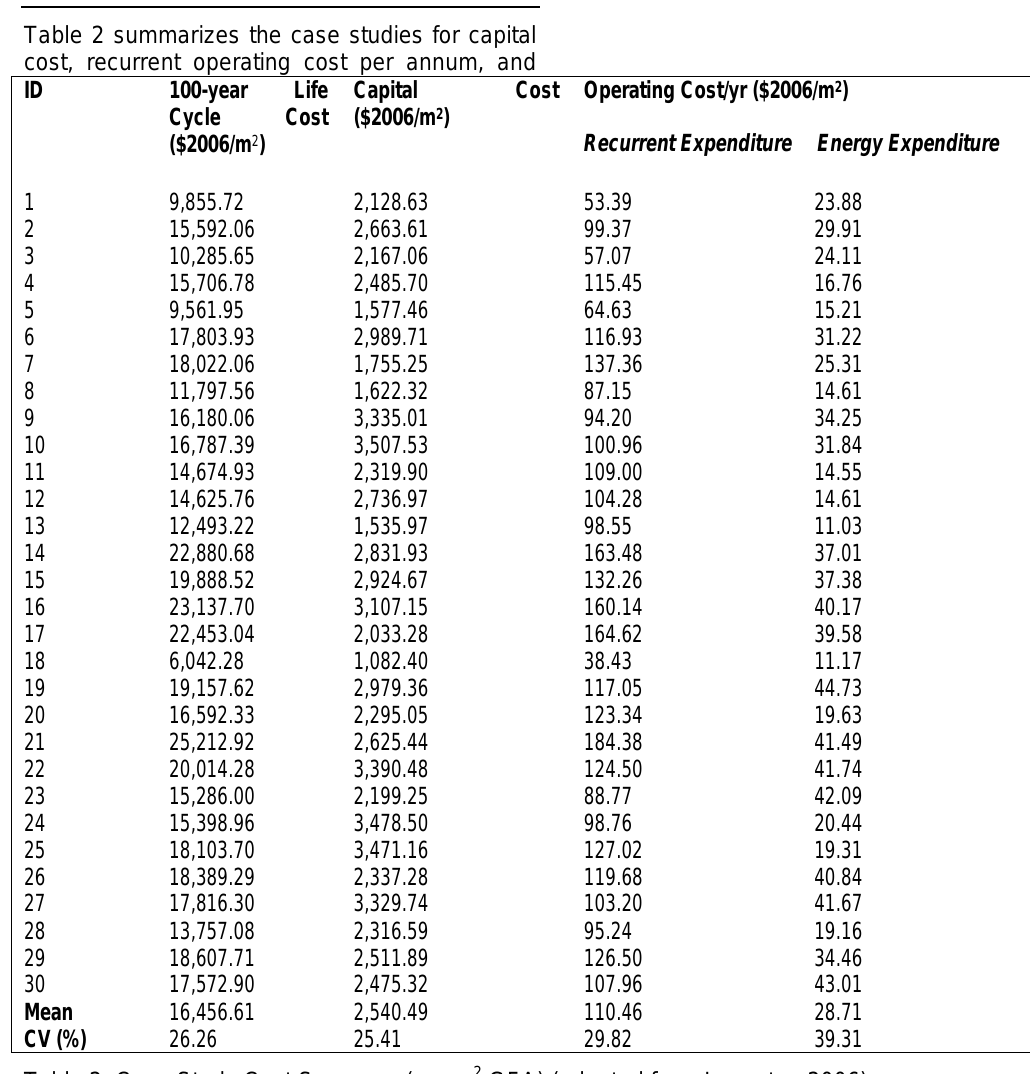
Table 2: Case Study Cost Summary (per m 2 GFA) (adapted from Langston